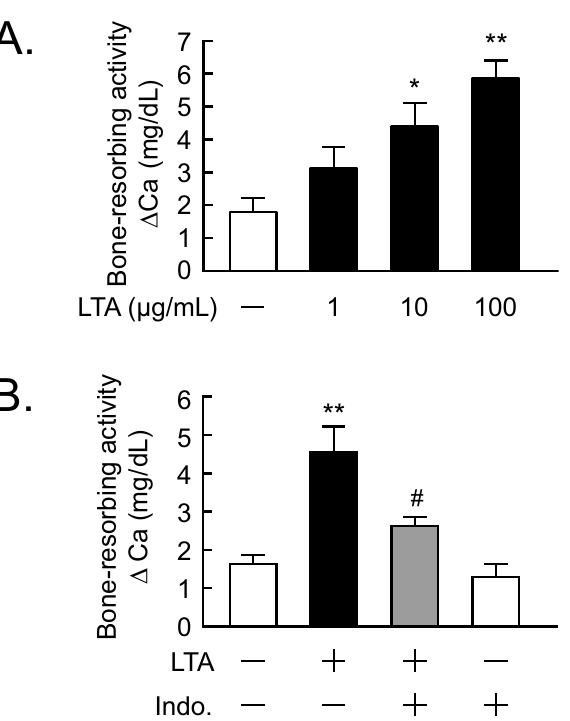
Figure 5. LTA induced bone resorption in an ex vivo mouse model of periodontal bone resorption for periodontitis. ( A ) Mouse alveolar bones were cultured with LTA (1, 10, 100 μg/mL) for 5 days. ( B ) Mandibular alveolar bones were cultured with LTA (100 μg/mL) in the presence or absence of indomethacin (10 μM) for 5 days. The calcium concentration was measured to elucidate bone-resorbing activity. The data are expressed as the mean ± SEM of 4 wells. A significant difference between the two groups was indicated; * P < 0.05 and ** P < 0.01 versus control, # P < 0.05 versus LTA; by one-way ANOVA and Tukey’s post hoc